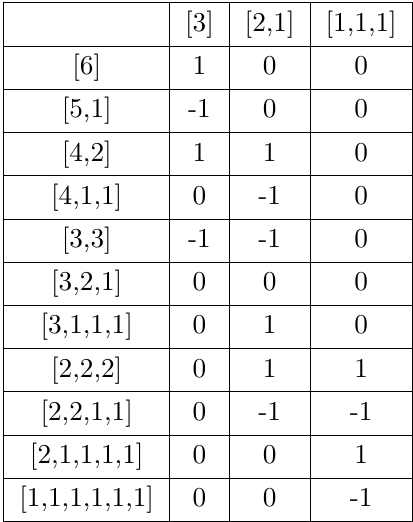
Table 1 . Reduced projection coe(cid:14)cients (cid:22) (cid:11) T at n = 6. The leftmost column indexes R ‘ n while R the top row indexes t ‘ n . The T in (cid:22) (cid:11) T is constructed from t by replacing each individual square R 2 in the Young diagram with a 2 (cid:2) 2